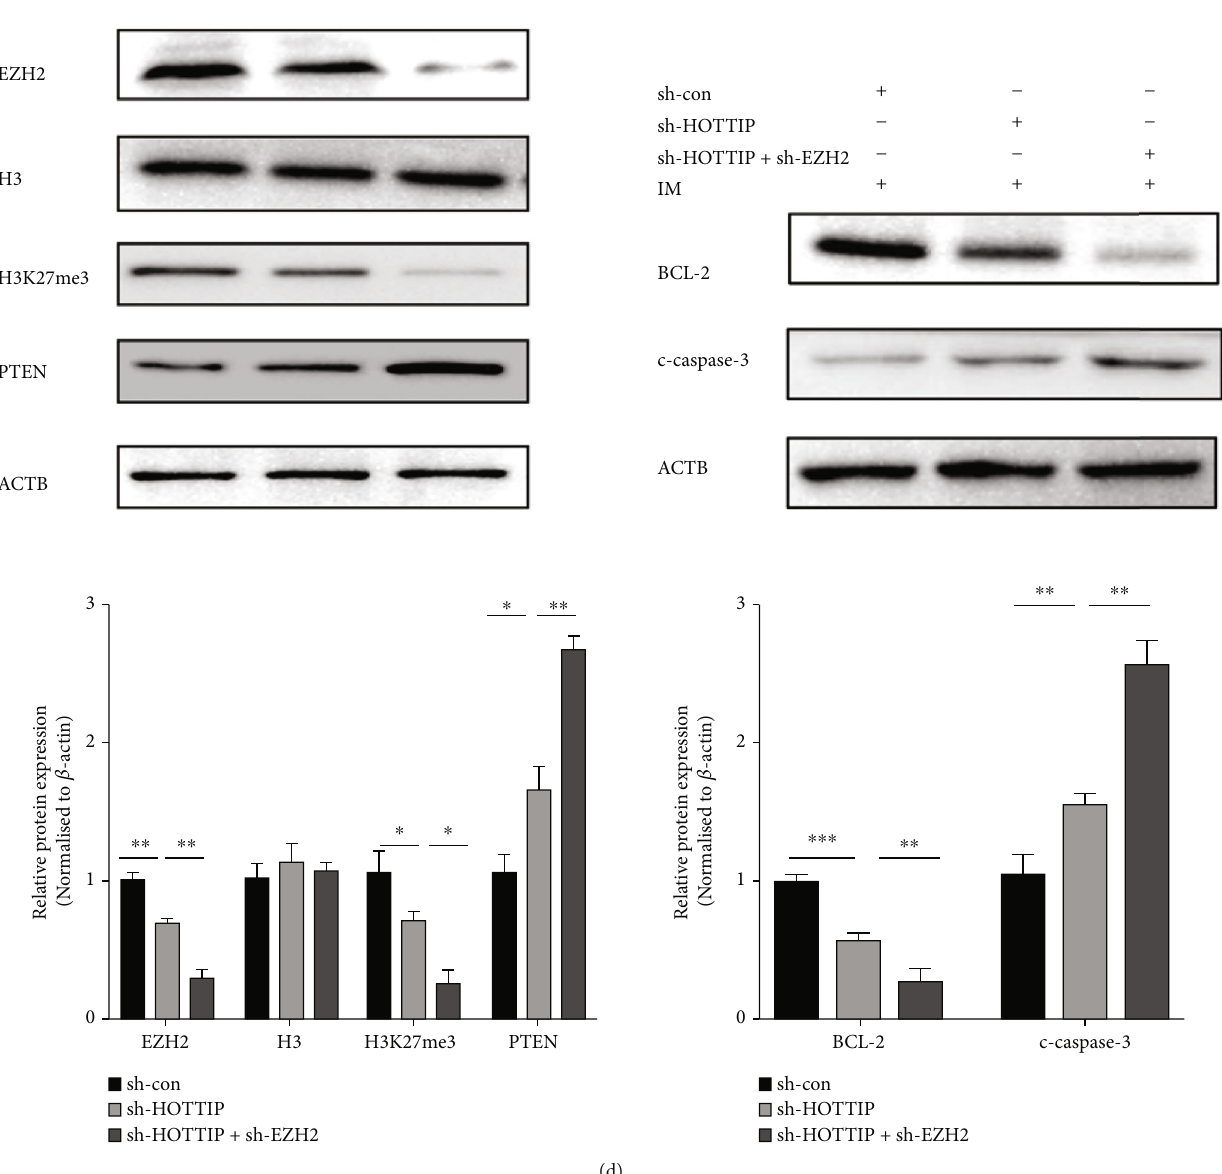
Figure 6: HOTTIP work through EZH2 to participate in drug resistance. Note: (a) IR-K562 cells were transfected with speci fi c sh-HOTTIP or both sh-HOTTIP+sh-EZH2. The CCK-8 analysis was used to detect cell proliferation. (b) Cell apoptosis was detected by fl ow cytometry using Annexin V/APC/PI. The right panel shows the apoptosis rate from three independent experiments. (c) IR-K562 cells were prepared with di ff erent Imatinib concentrations for 48h. The CCK-8 analysis was used to detect cell inhibition. (d) WB was used to detect protein